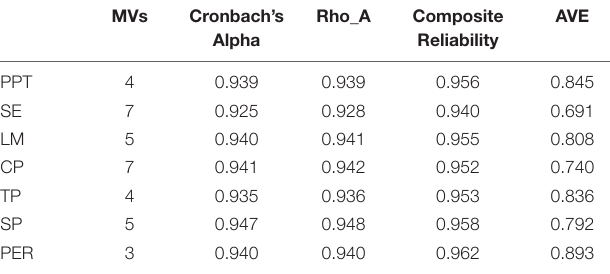
TABLE 3 | Construct reliability and validity.